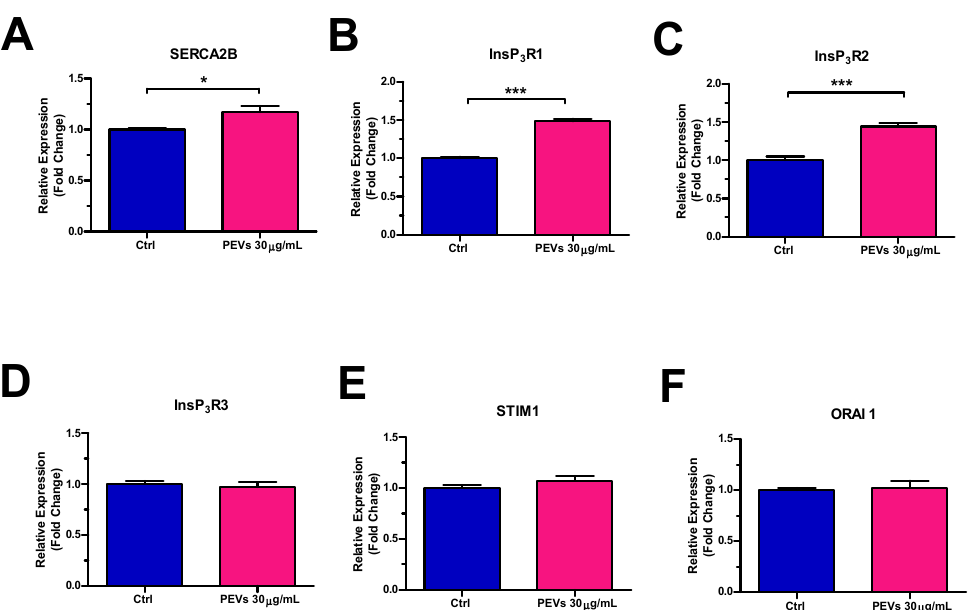
Figure 3. Long-term exposure to PEVs enhances the expression of SERCA2B, InsP 3 R1 and InsP 3 R2 transcripts. RT-qPCR was performed on the transcripts encoding for SERCA2B ( A ), InsP 3 R1 ( B ), InsP 3 R2 ( C ), InsP 3 R3 ( D ), STIM1 ( E ), and Orai1 ( F ) and harvested from MDA-MB-231 cells treated with 30 µ g/mL for 24 h as compared to untreated (Ctrl) cells. Results were normalized with the level of the GAPDH control. * indicates p < 0.05, *** indicate p < 0.001. Next, western blot analysis of SERCA2B, InsP 3 Rs, STIM1, and Orai1 protein expression was performed by exploiting affinity-antibodies, as illustrated in [37,40,53]. Immunoblots revealed a major band of ≈ 115 kDa for SERCA2B (Figure 4A, left panel) and a large band over 250 kDa, deriving from the sum of the 313/260/250 kDa bands corresponding to InsP 3 R1, InsP 3 R2, and InsP 3 R3 (Figure 4B, left panel), as previously shown in [53]. Fur- thermore, two major bands of ≈ 86 and ≈ 35 kDa were detected for, respectively, STIM1 (Figure 4C, left panel) and Orai1 (Figure 4D, left panel). Densitometric analysis confirmed that SERCA2B (Figure 4A, right panel) and InsP 3 R (Figure 4B, right panel) proteins were significantly up-regulated in MDA-MB-231 cells exposed to PEVs (30 µ g/mL; 24 h). Con- versely, and in agreement with the qRT-PCR data, there was no significant difference in the expression level of STIM1 (Figure 4C, right panel) and Orai1 proteins (Figure 4D, right panel). Overall, these findings strongly suggest that the increase in the amount of ER Ca 2+ that is releasable through InsP 3 Rs is due to the overexpression of SERCA2B and InsP 3 R proteins. Since there is no difference in the expression levels of its underlying constituents, i.e., STIM1 and Orai1, the increase in SOCE is likely to reflect the larger drop in ER Ca 2+ concentration following agonist stimulation of MDA-MB-231 cells pre-exposed to PEVs